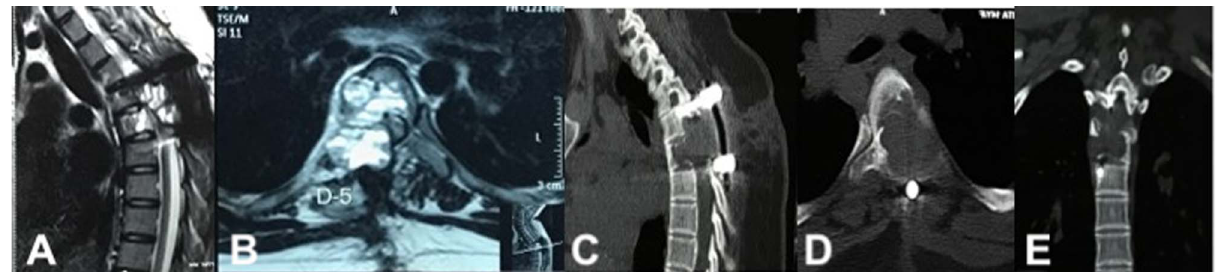
Figure 2. Post-operative day 2 MRI showing surgical mass compressing dorso-laterally from right (A, B), CT scan depicting the extent of bony destruction (C – E) with pedicle screw fi xation and excision of